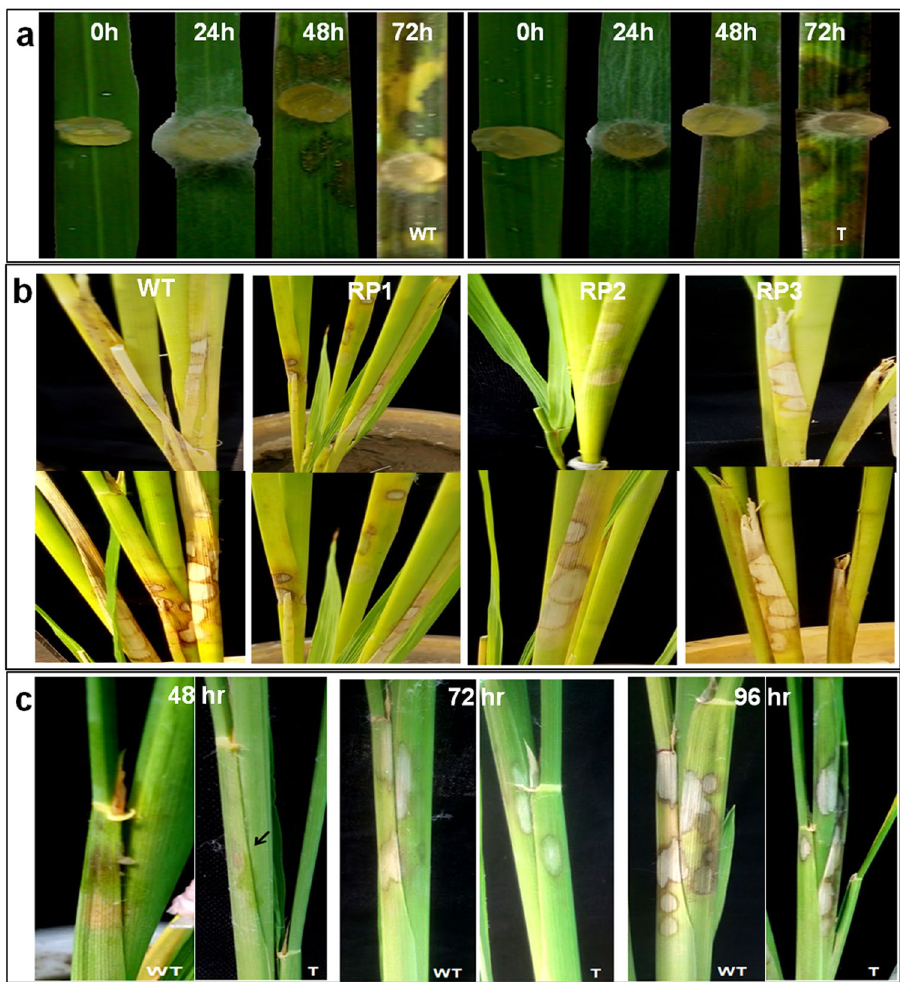
Figure 6. Transgenic plants with RNAi constructs exhibiting enhanced resistance against the sheath blight pathogen Rhizoctonia solani . ( a ) Detached leaf bioassays of transgenic lines and non-transgenic controls. ( b ) Whole plant of transgenic lines RP1, RP2 and RP3 and non-transgenic controls. ( c ) Whole plant bioassays of homozygous T2 plants from the RP1 line and non-transgenic